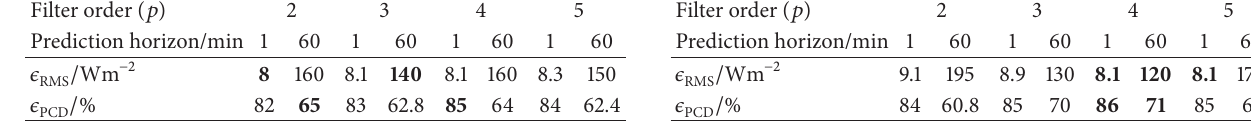
Table 3: Solar radiation prediction results for a two- state MARM. Filter order ( 𝑝 ) 2 Prediction horizon/min 1